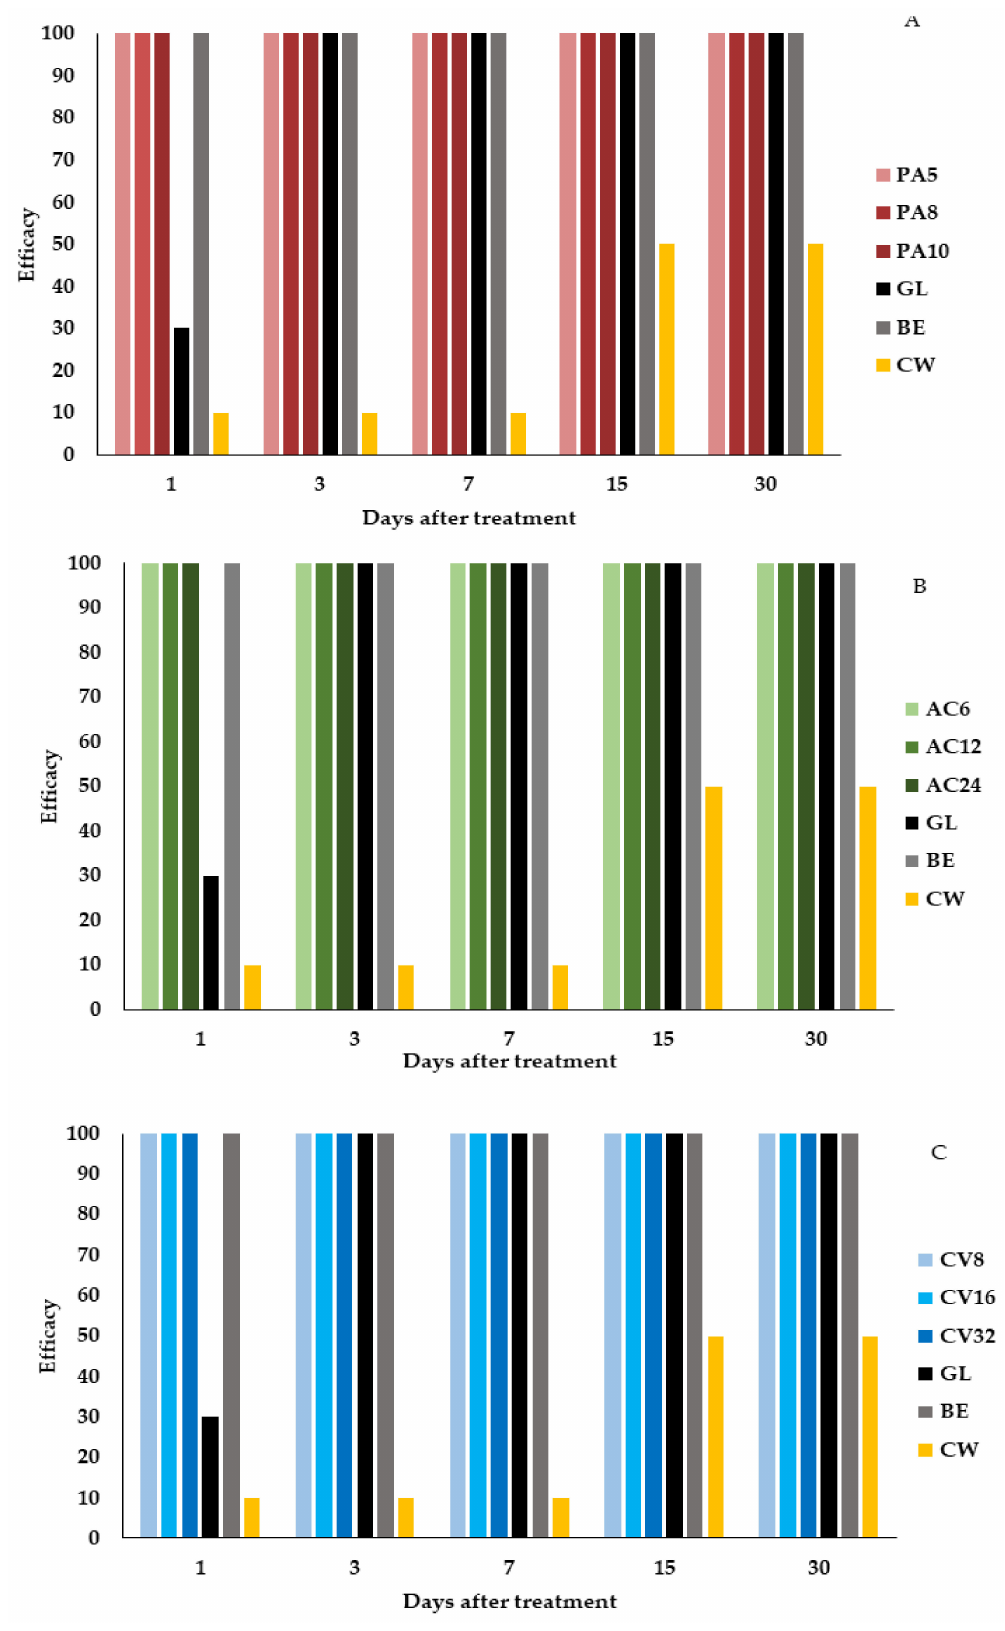
Figure 4. Evolution of e ffi cacy of the tested treatments ( A ) pelargonic acid, ( B ) cinnamic aldehyde and ( C ) carvacrol in A. retroflexus during 30 days after